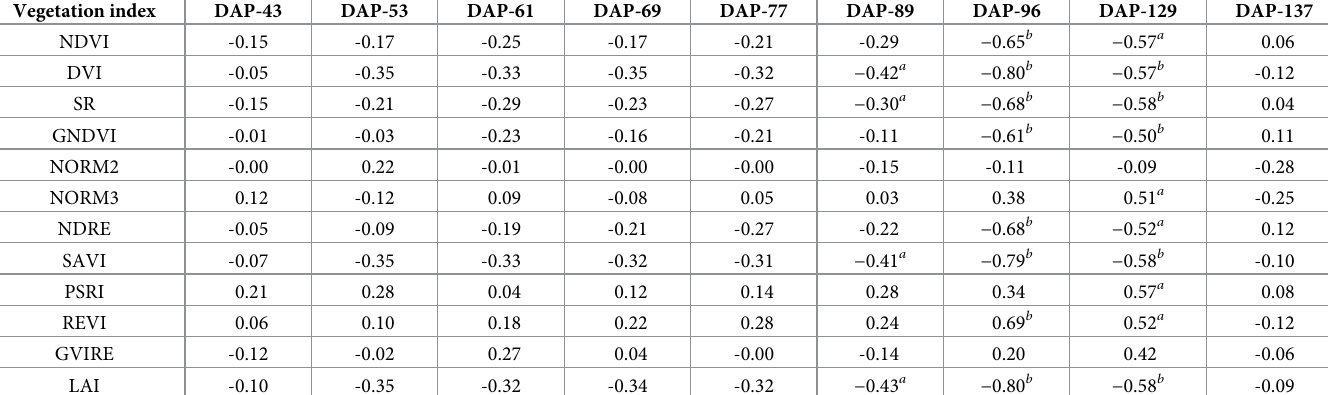
Table 2. The correlation coefficient between the LLS at DAP-112 and VI images taken in various peanut growth stages. Note that a,b represents the correlation at 0.01 and 0.05 level of significance respectively. Vegetation index